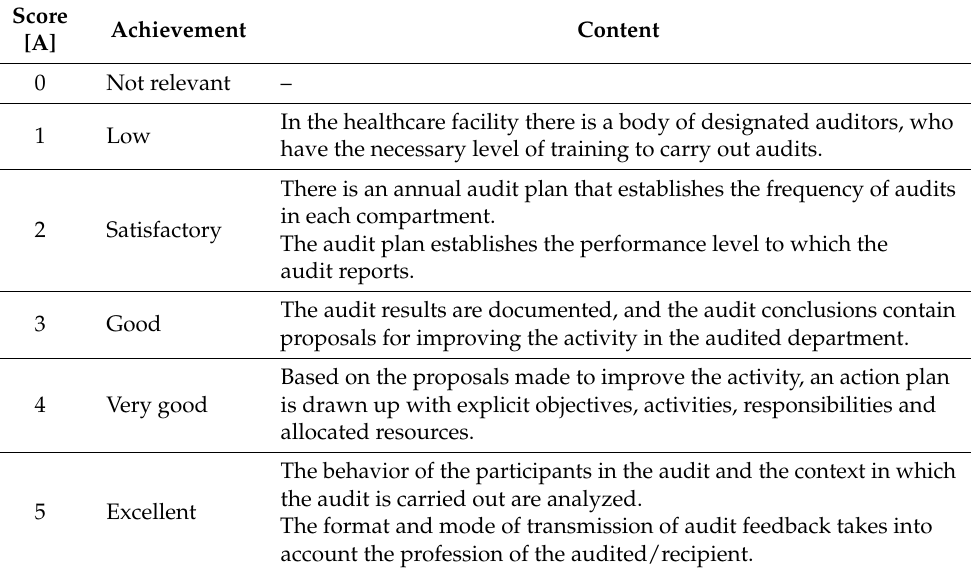
Table A16. Scale for indicator RA3—Audit and feedback.